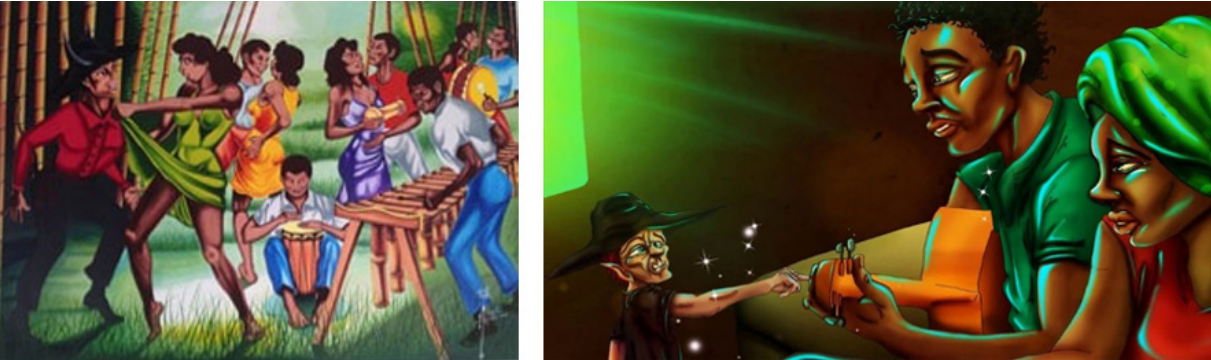
Figure 3. Graphic representations of the devil and the minstrel in Marimba Esmeraldeña and Bomba del Chota. From left to right: A painting of the devil in the middle of a performance of Marimba, by Esmeraldeño Alberto Acosta (photograph taken by María Gabriela López‐Yánez during an exhibition in Esmeraldas, Ecuador, in 2017); an illustration by the Ecuadorian Iván Guamán of the minstrel talking to a Bombero (Guamán, 2015, p.